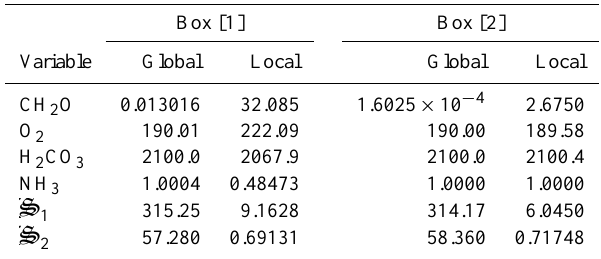
Table 5. Steady state concentration (mmol m − 3 ) of state variables at maximum internal entropy production associated with local and global solutions.